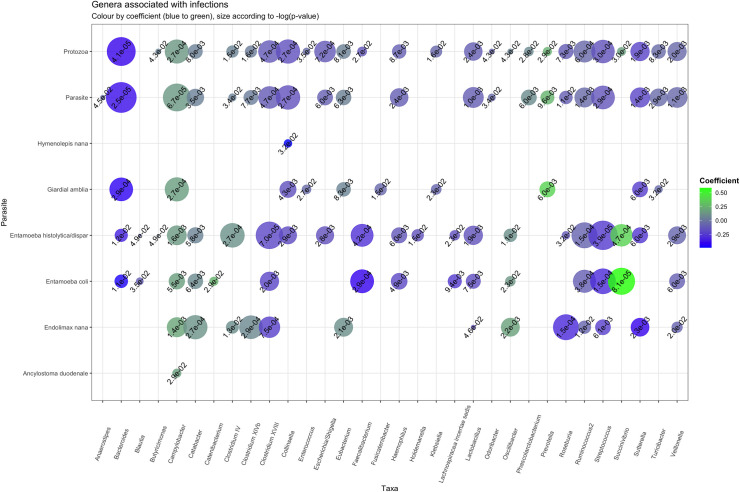
Specific taxa are altered by different parasitic species.A total of 32 genera are significantly associated with intestinal parasitic infection, either overall infections or specific parasite species. Most associations are seen with protozoan infections, whereas helminth infections have limited effects on taxa alterations. The figure illustrates significant associations between genera and different parasite infections (linear regression, P.adj<0.05). Summary statistics for the shown associations are given in Table 4. The color illustrates coefficient (blue for low values, green for high values), whereas size illustrates the significance (calculated by -log(p-value) (the larger bubble, the higher significance). The plot is made using ggplot2 package in R.